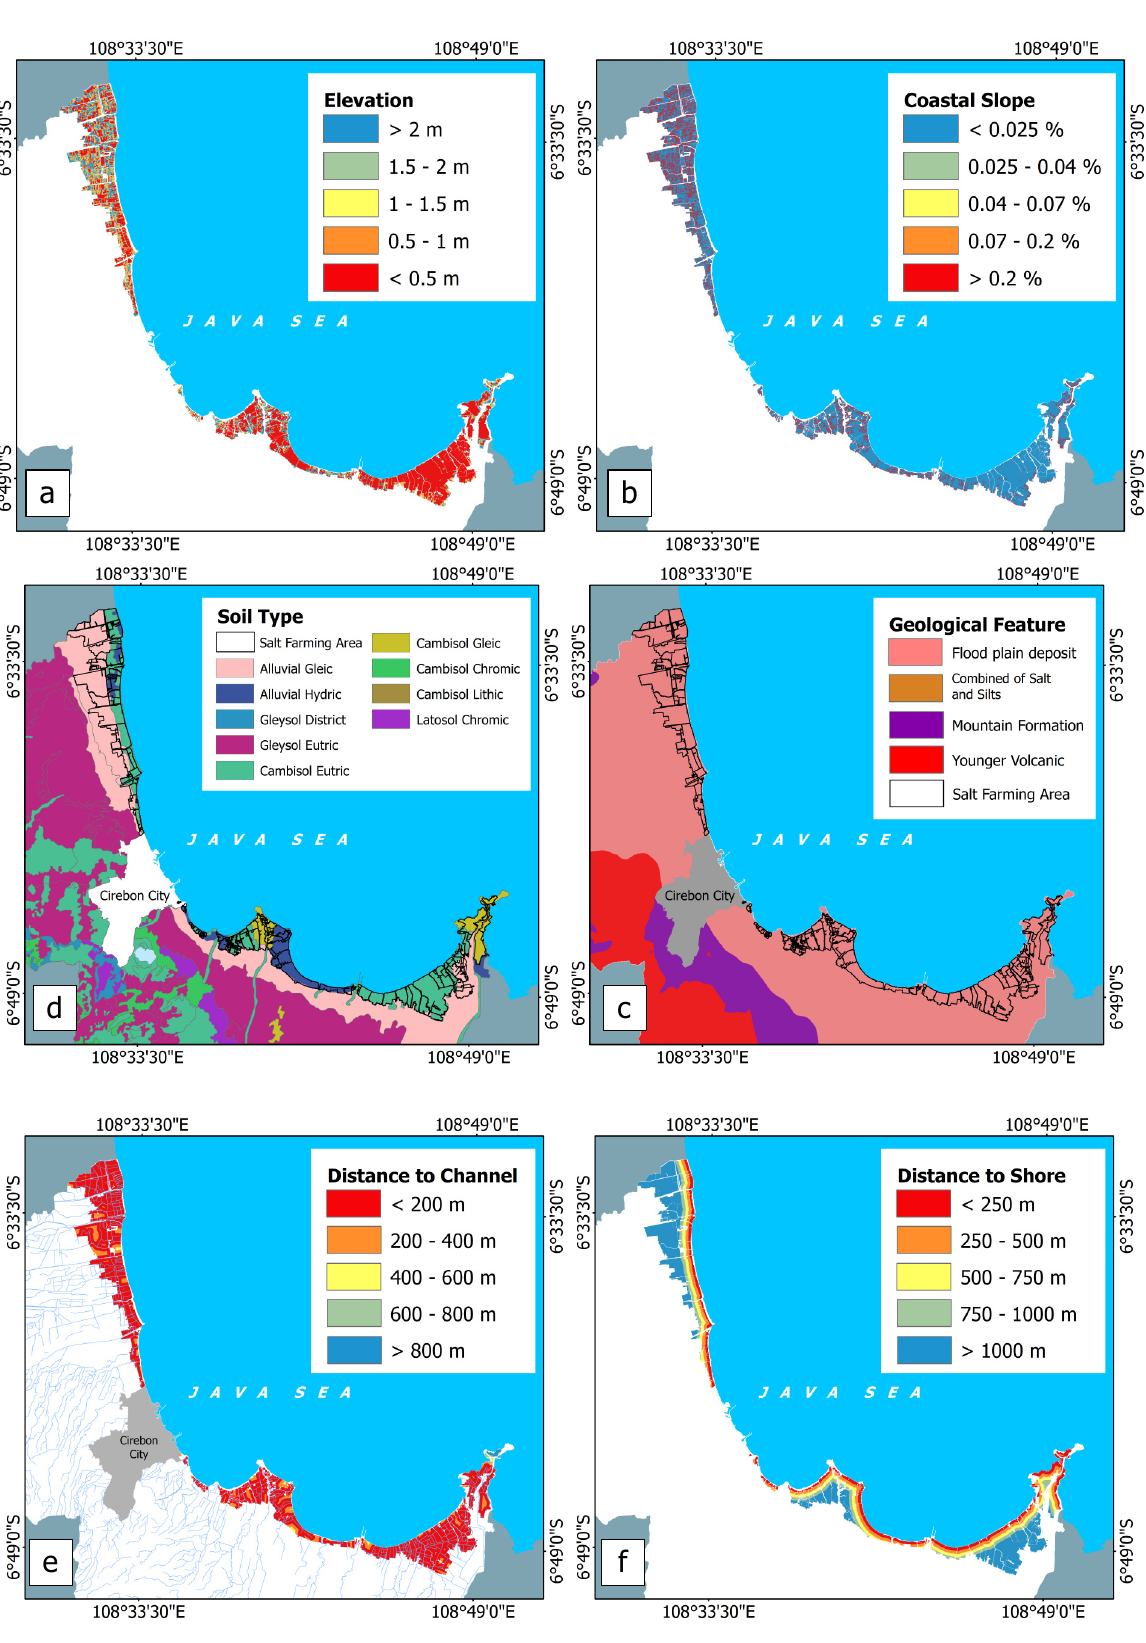
Figure 4. Maps showing the spatial distribution of vulnerability variables selected for this research including ( a ) elevation (V 1 ), ( b ) coastal slope (V 2 ), ( c ) geological features (V 3 ), ( d ) type of soil (V 4 ), ( e ) distance to channel (V 5 ), and ( f ) distance to shore (V 6 ).